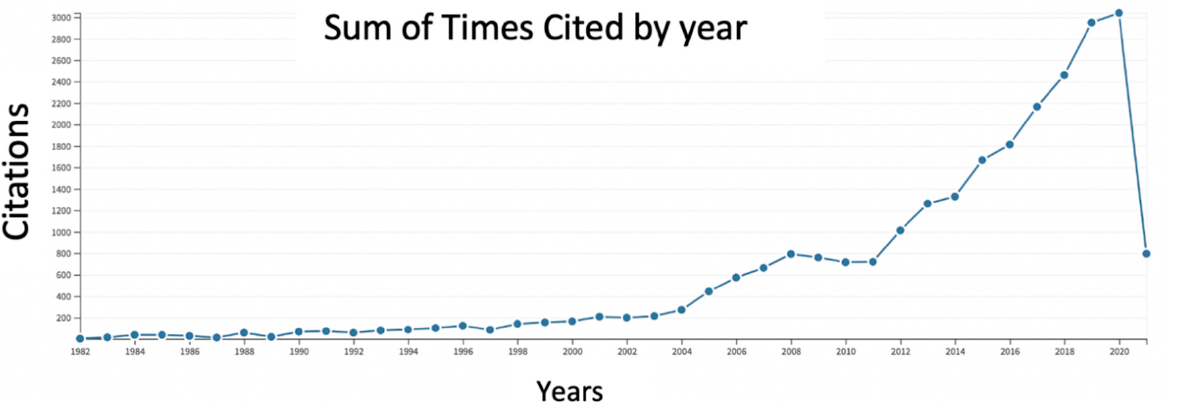
Figure 19. Citation report for 1001 results from the Web of Science Core Collection by the author Witold Pedrycz.